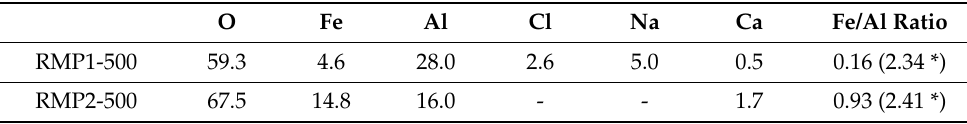
Table 7. Atomic percentages from XPS analyses of elements in precipitated red mud samples cal- cined at 500 °C.